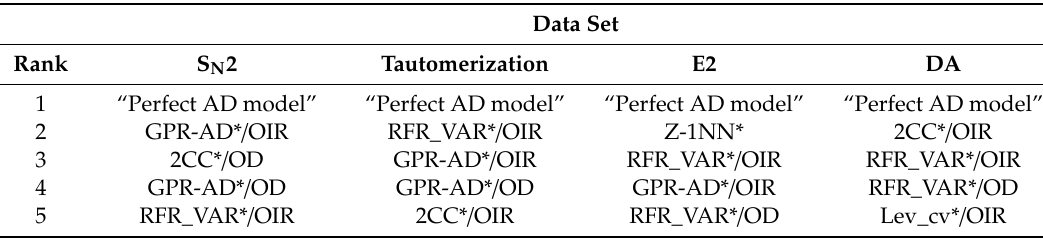
Table 4. Ranking of di ff erent AD definition